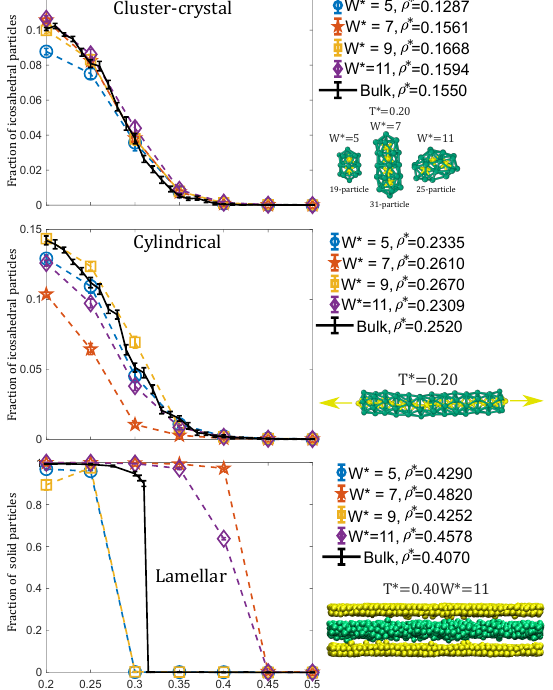
Figure 5. Density profiles along the z -direction at different temperatures and slit widths.